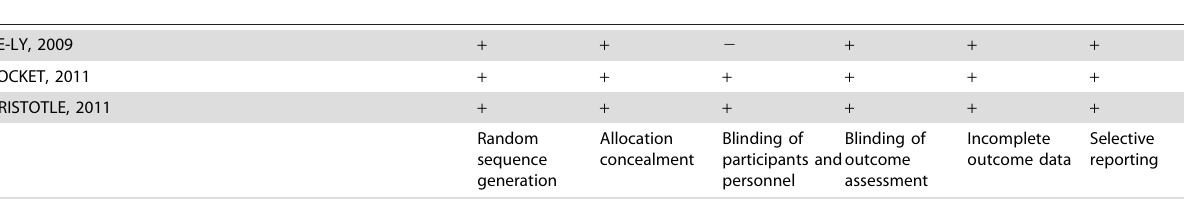
Table 2. Assessment of the risk of bias according to the Cochrane Collaboration’s